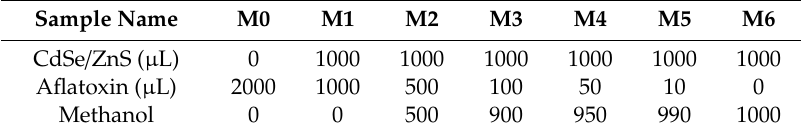
Table 1. Concentrations of aflatoxin B1 (AFB1) and CdSe / ZnS for each